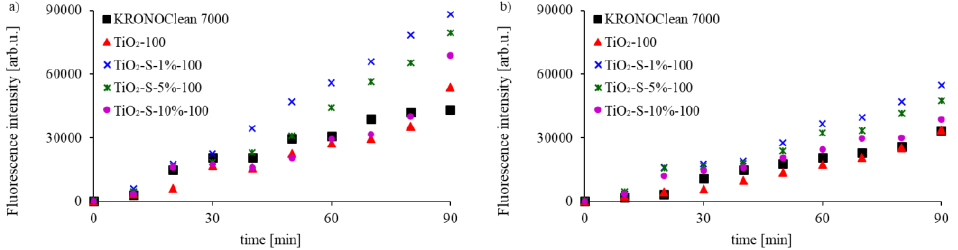
Figure 5. The fluorescence spectra of 2-hydroxyterephthalic acid product of the reaction of terephthalic acid with · OH radical taken after different reaction times ( a ) under UV-A irradiation and ( b ) ASL irradiation.